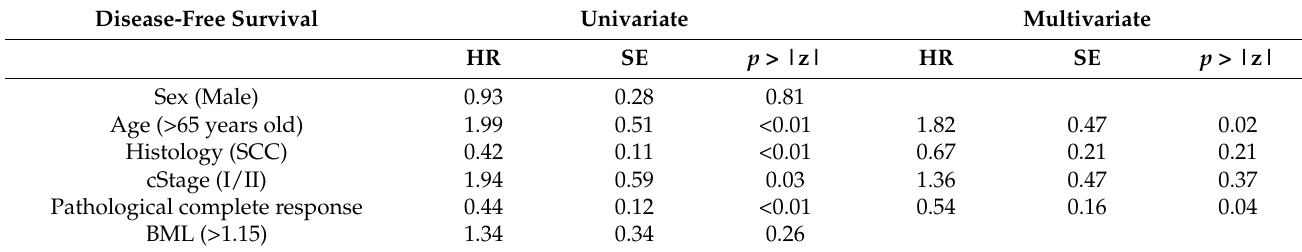
Figure 4. Kaplan–Meier analysis of disease-free survival. Patients were grouped in low bone marrow-to-liver SUV (BML ≤ 1.15) and high BML (>1.15). Table 3. Cox regression. Univariate and multivariate analysis for disease-free survival. SCC: Squamous cell carcinoma; SE: Standard error; bone marrow-to-liver SUV ratio (BML).